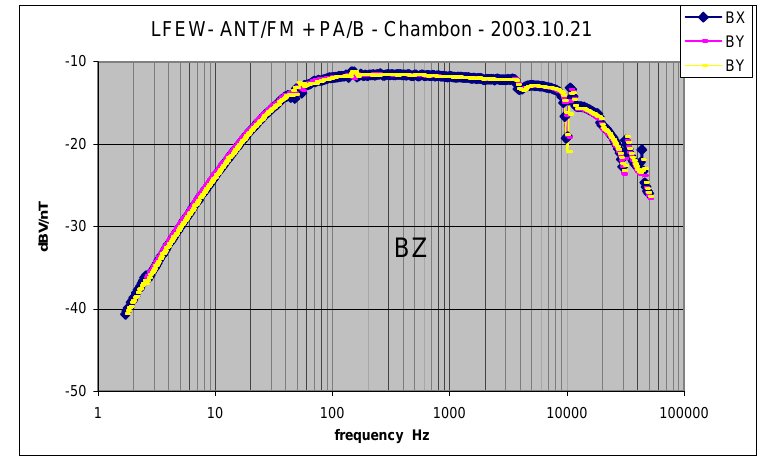
Fig. 2 The transfer functions of three axis search coils of LFEW of TC-2. Fig. 2. The transfer functions of three axis search coils of LFEW/TC-2.